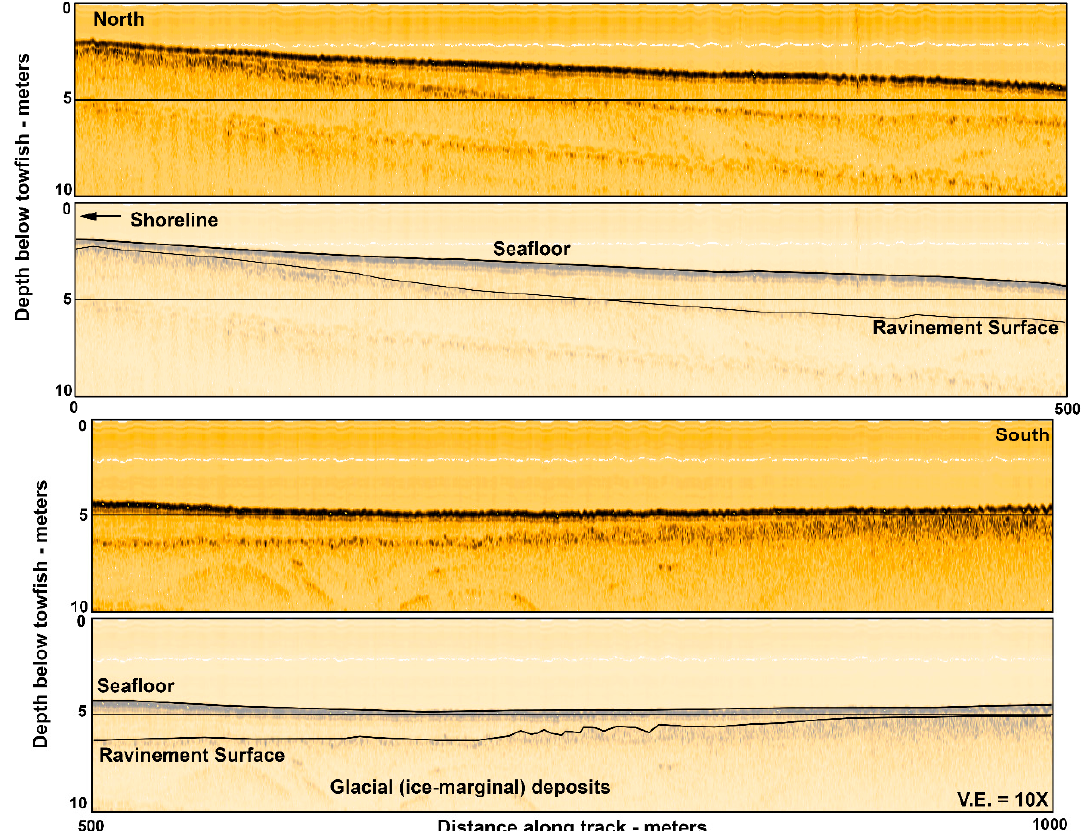
Figure 3. Shore perpendicular seismic reflection profile from the northwest corner of the HoR extending from the upper shoreface south toward the center of the harbor, showing the seismic unit overlying the ravinement surface. See Figure 1 for the location of the survey line. Vertical exaggeration is 10× for both profiles; differences in the horizontal scale are due to slight differences in vessel speed during the survey.